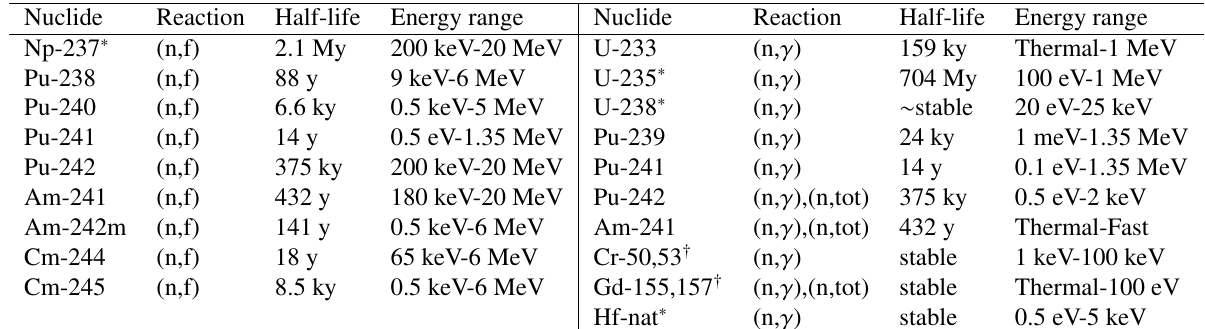
Table 2. Fission and capture cross section requests relevant to nuclear